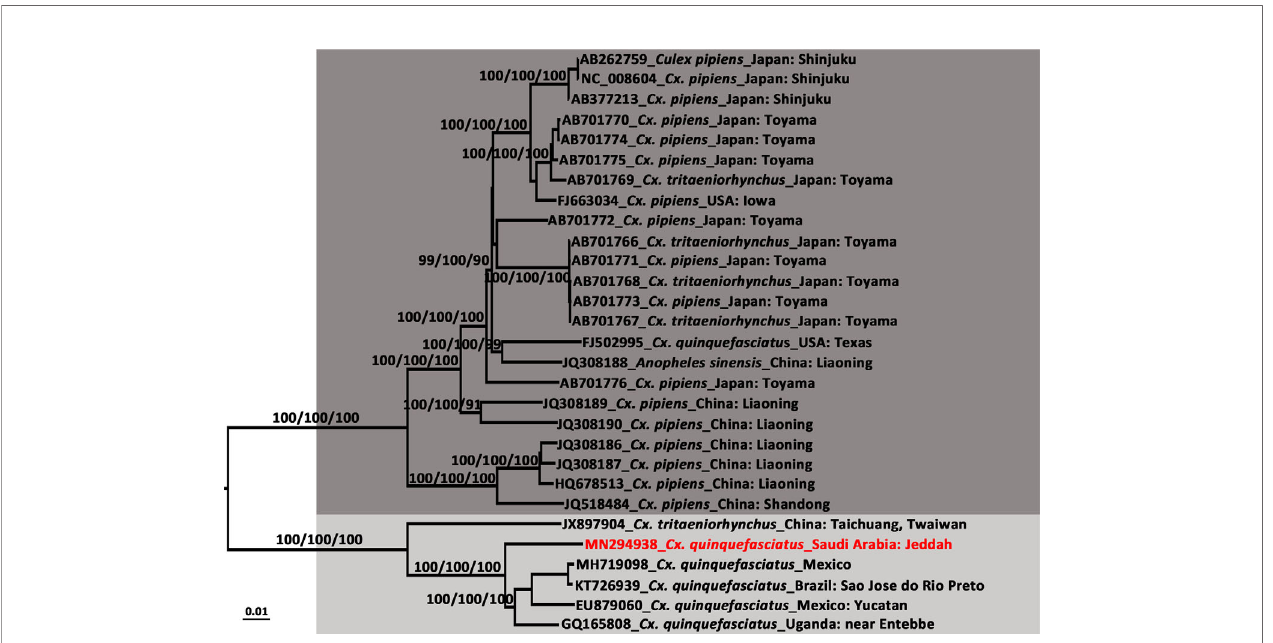
FIGURE 5 | Phylogenetic tree generated by Bayesian analysis of Culex fl avivirus (CxFV) complete genome. The GenBank accession number, host species and origin are noted. The CxFV sequences obtained in this study are marked in red. Bootstrap values (1,000 replicates, not shown for less than 75%) of Bayesian analyses, maximum likelihood and neighbor-joining are shown above the main lineages. The scale-bar indicates 0.01 substitutions per site. Dark gray and light gray indicate CxFV Asian/USA genotype and Africa/Caribbean/Latin America genotype,